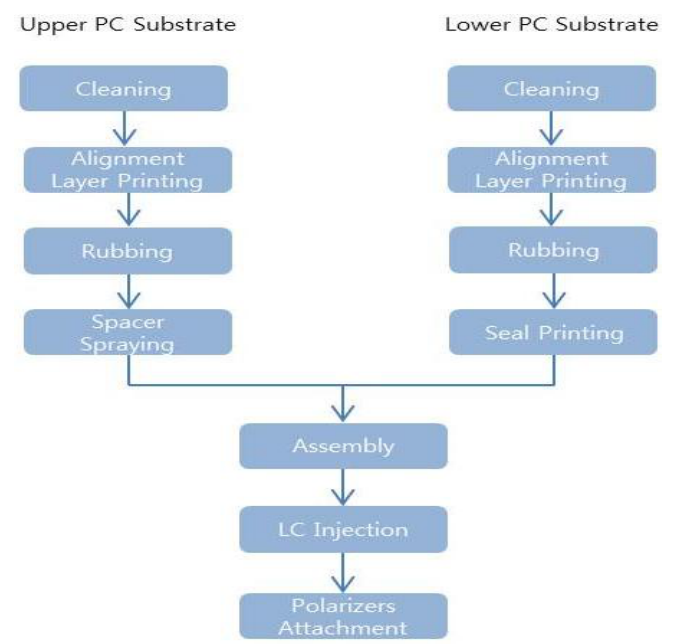
Figure 1. Flow chart of the fabrication process for the flexible liquid crystal lens.